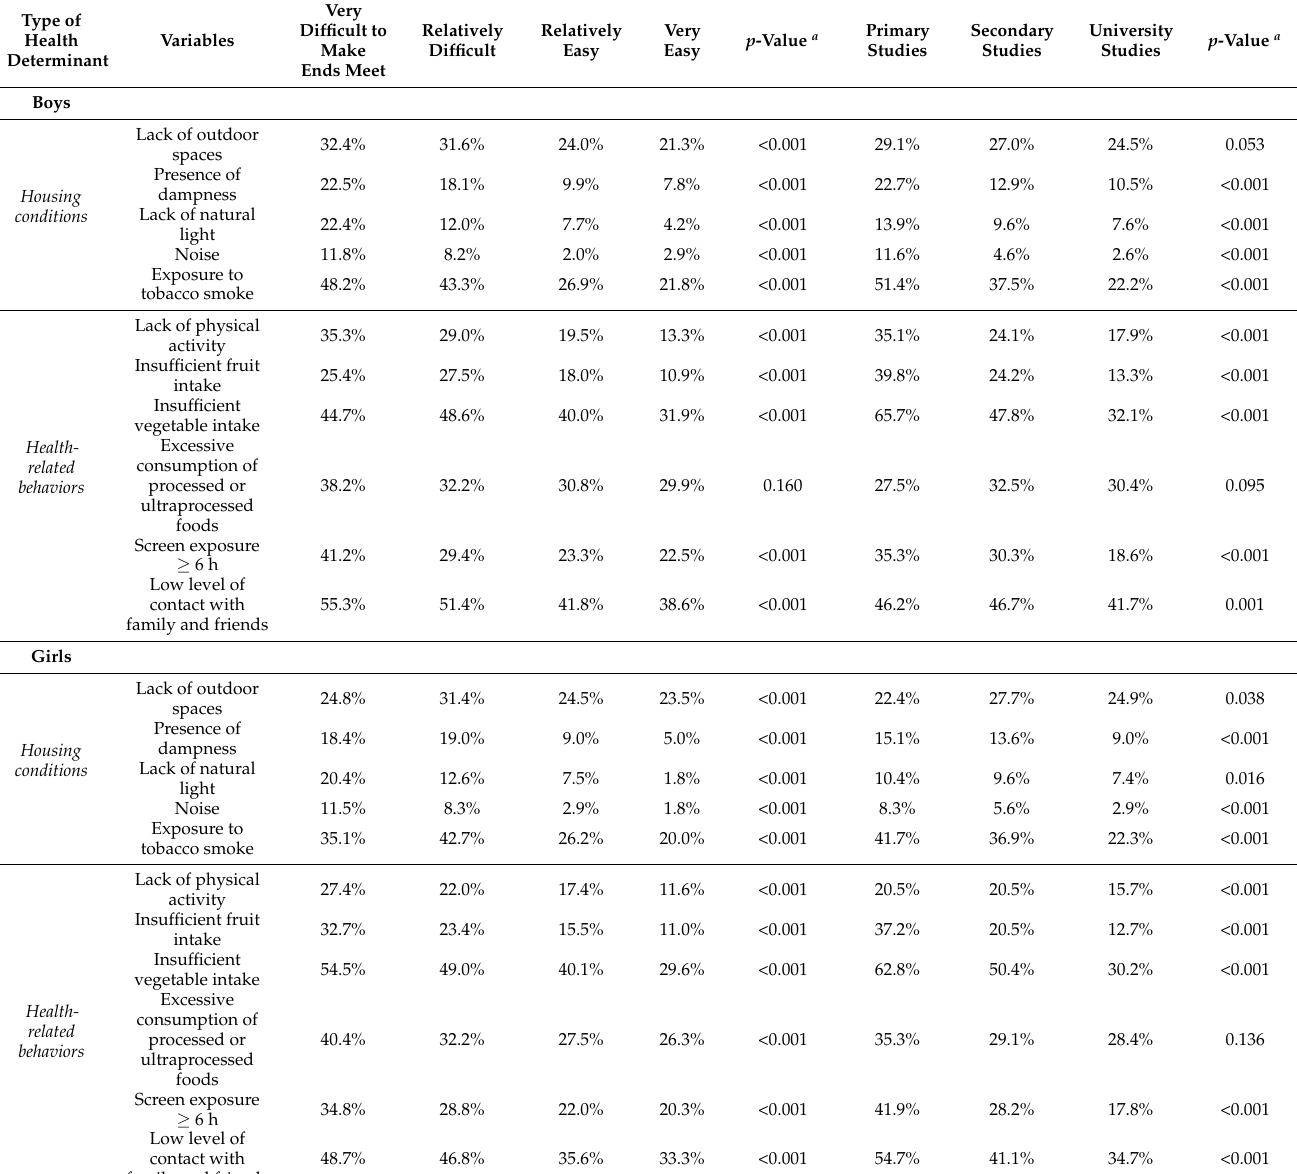
Table 2. Prevalence of housing conditions and health-related behaviors according to the household’s financial situation and parents’ educational